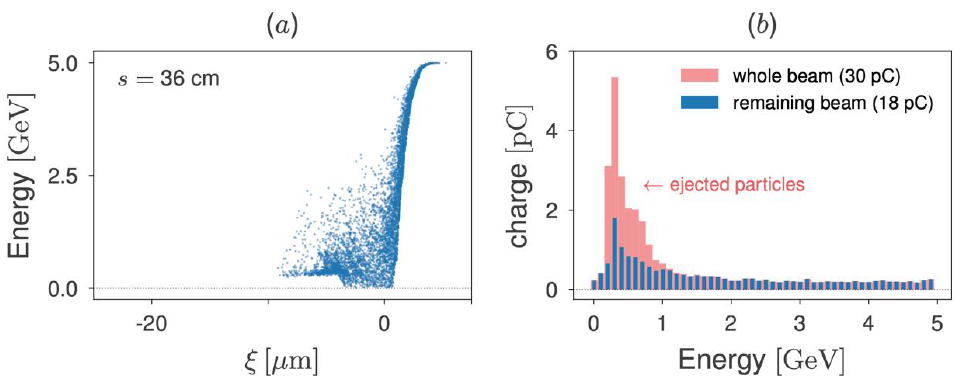
Figure 7. ( a ) The EuPRAXIA 5 GeV beam longitudinal phase space and ( b ) energy spectrum, after 36 cm propagation in plasma, for the EuPRAXIA 5 GeV beam. Compared to Figure 5a, this figure shows that the density profile from Figure 6 is e ff ective in eliminating the lower energy particles reaching the accelerating wakefield phase, thus preventing the formation of a re-acceleration peak. The energy spectrum for the remaining beam (18 pC, at this propagation distance) is represented by the blue columns in panel ( b ). In addition, the light-red shaded region shows the energy and charge distribution for the whole beam, including the transversely ejected